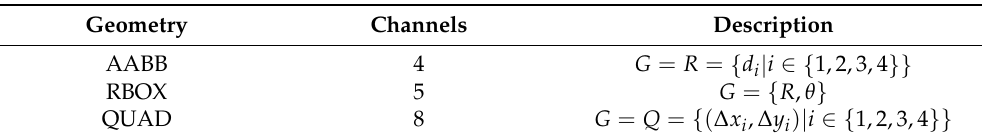
Table 1. EAST algorithm